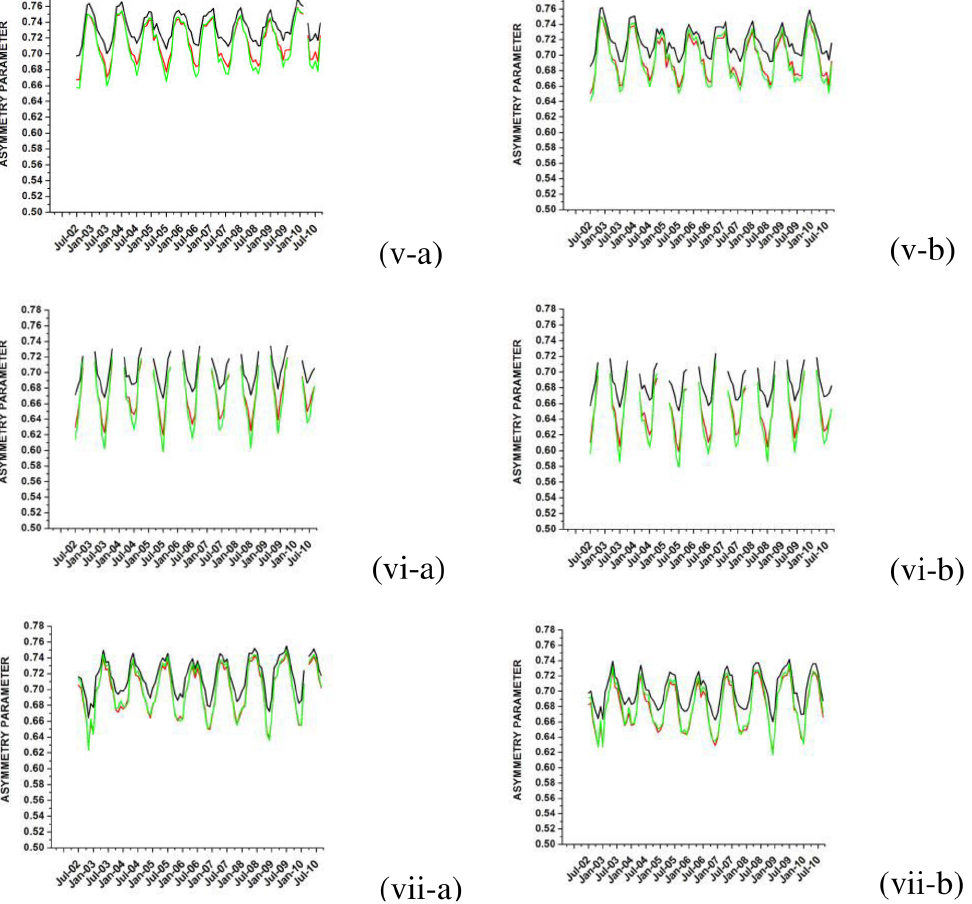
Figure 6. Inter-annual (2002–2010) variation of monthly mean g aer values at 470, 660, and 860nm (in black, red and green colours, respec- tively), over the sub-regions of (i) Black Sea, (ii) eastern Atlantic Ocean, (iii) Mediterranean Sea, (iv) Middle East, (v) northeastern Atlantic Ocean, (vi) northern Europe and (vii) Persian Gulf. Results are given based on MODIS-Terra ( -a , left column) and MODIS-Aqua ( -b , right